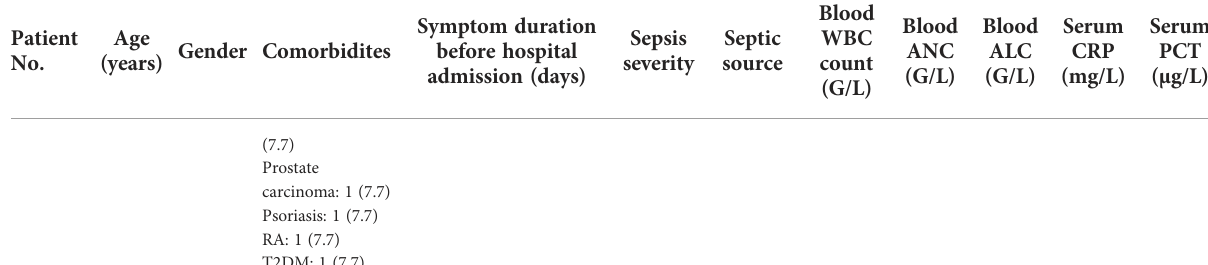
TABLE 2 Microbiological characteristics, antimicrobial therapies and outcomes of septic patients included in the study. Patient Species isolated No. from blood cultures